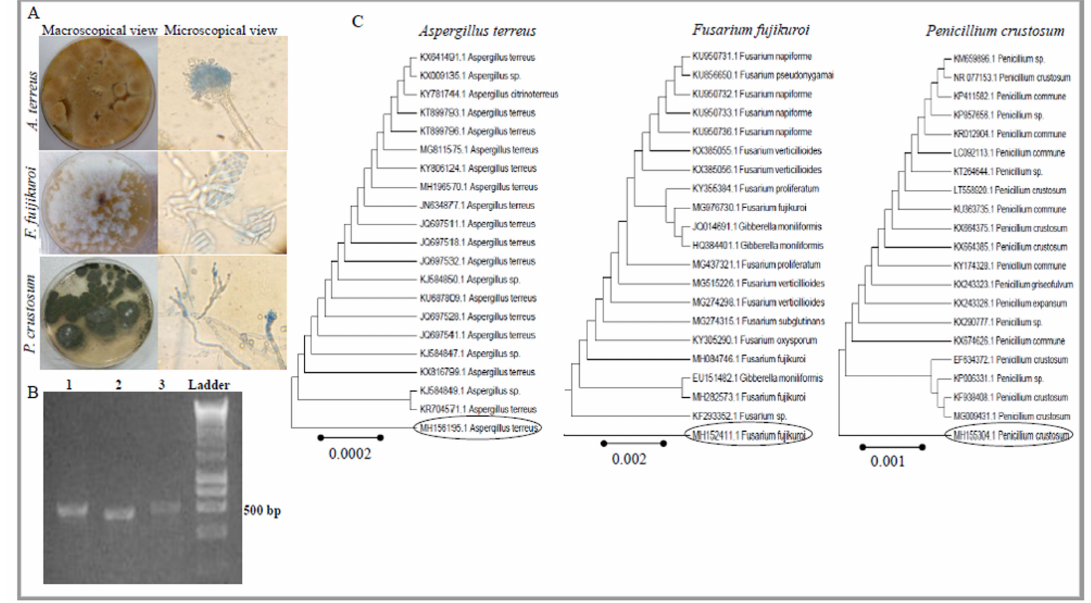
Figure 1. Morphological and molecular identification of the potent ODC-producing fungal isolates. TheisolatesweregrownonPDAmedium, incubatedfor8daysat30 ◦ C,thenphotographedbythedigital camera and examined by light microscope. ( A ) The macroscopical (left side) and microscopical (right side) views of A. terreus , F. fuijikuroi and P. crustosum . ( B ) The PCR amplicon of ITS region